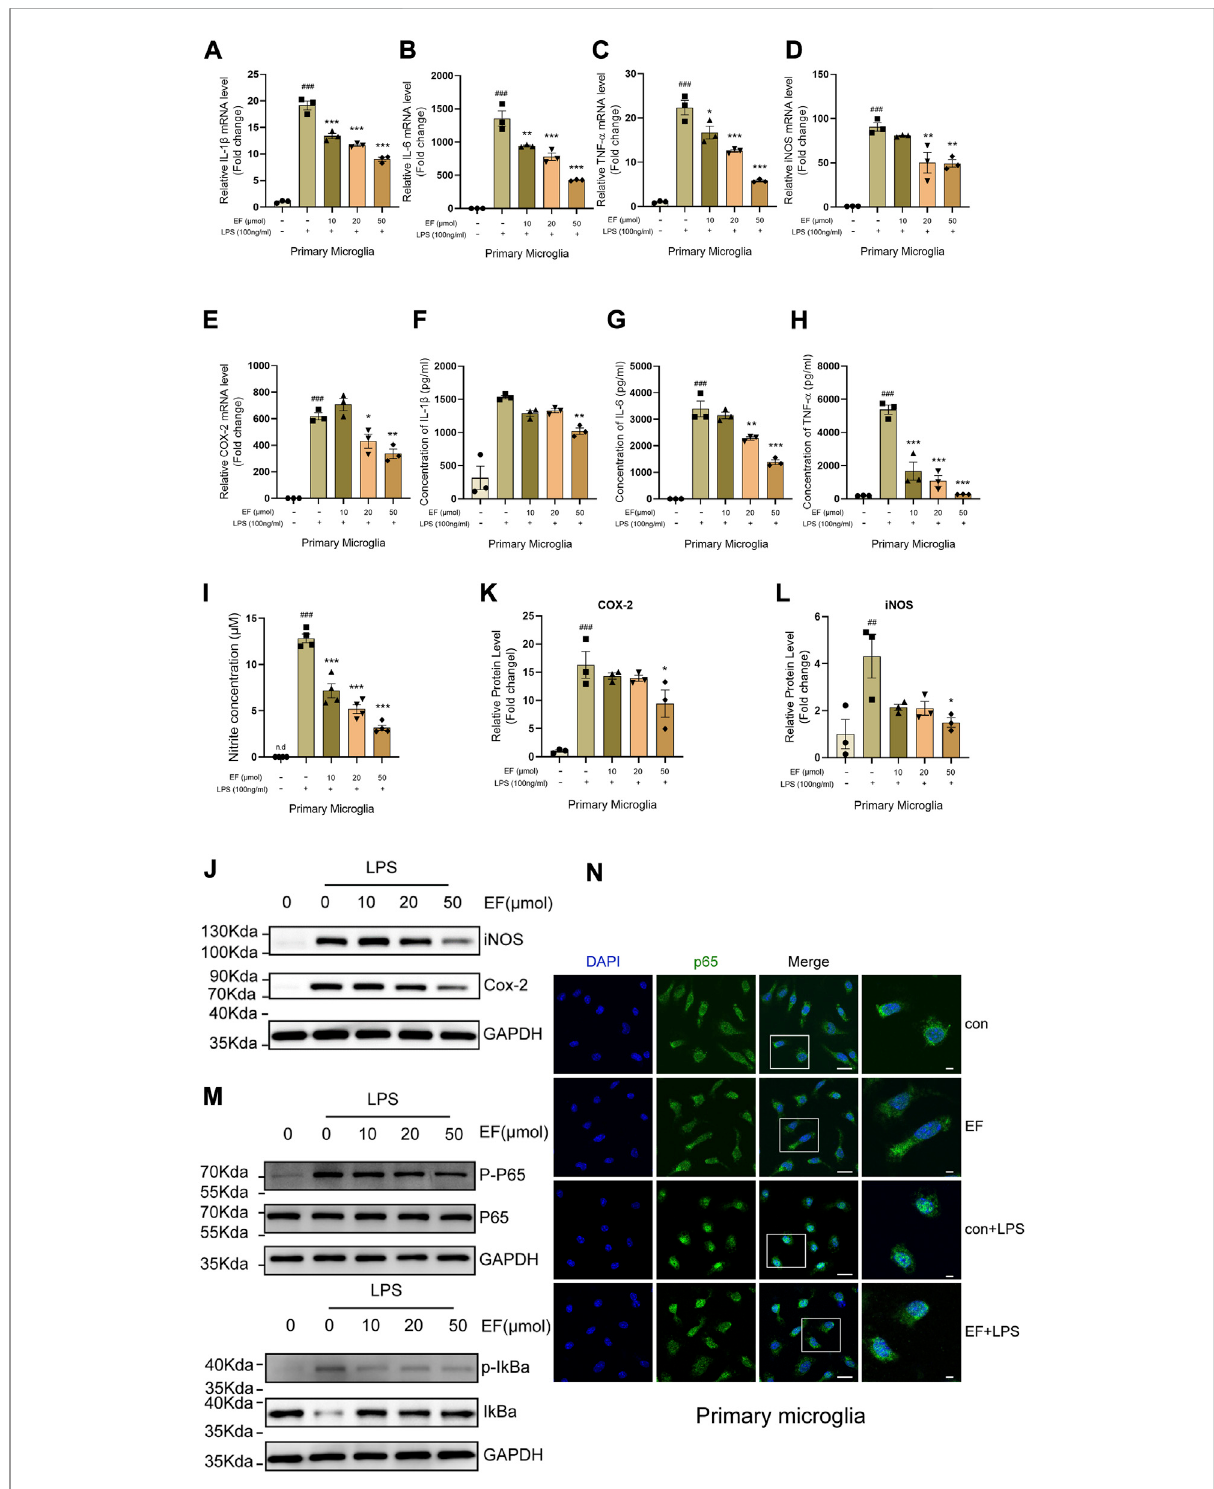
FIGURE 2 EF suppresses LPS-induced proin fl ammatory response in primary microglia. Primary microglia were treated with/without EF in different concentrations for 2h, prior to LPS (100 ng/ml) -stimulation. (A – E) The mRNA levels of IL-1 β (A) , IL-6 (B) , TNF- α (C) , iNOS (D) and COX-2 (E) were quanti fi edbyRT-qPCR. (F – I) TheproteinlevelsofIL-1 β (F) ,IL-6 (G) andTNF- α (H) weredetectedusingELISAsandtheconcentrationsofNO (I) inthe supernatant were tested using the Griess reaction kit. (J) The protein levels of iNOS and COX-2 in cell lysates were measured by western